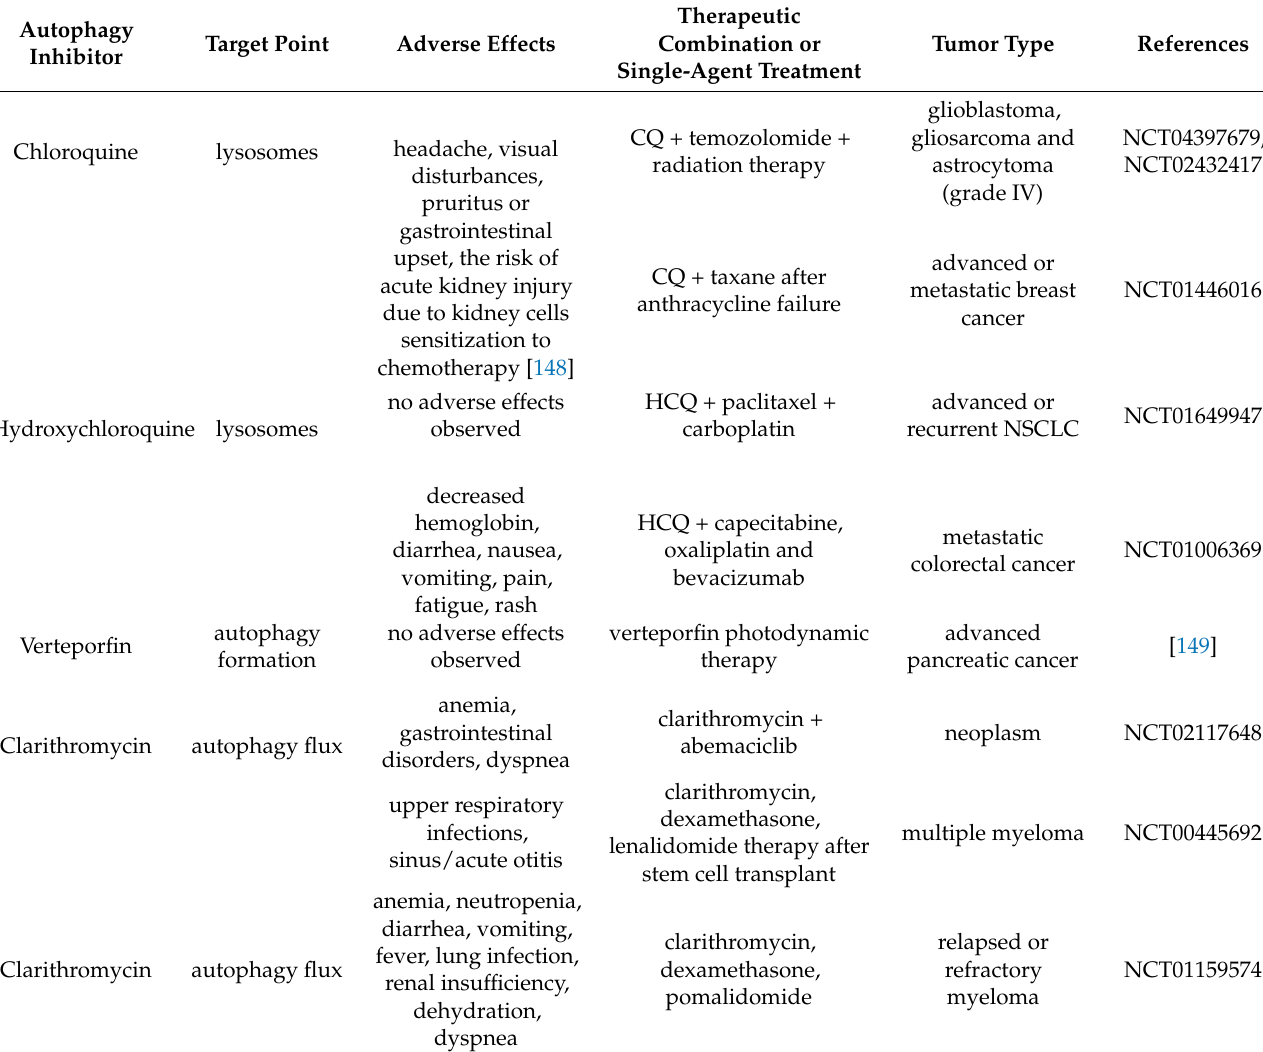
Table 2. Target points, adverse effects and selected therapeutic schemes of autophagy inhibitors.